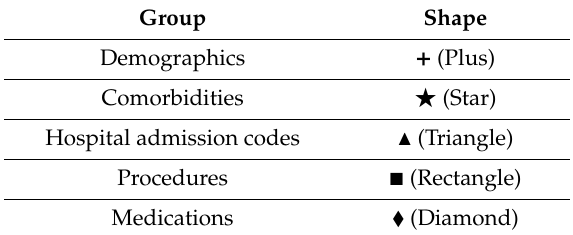
Figure 5. Showing an overview of the projected-features subview, which includes ( A ) all glyphs with respect to dimensions one and two, ( B ) some selected glyphs and labels with regard to dimensions three and four, and ( C ) all the glyphs and labels representing age upon drilling. Table 2. Showing the shapes of the glyphs based on di ff erent groups of